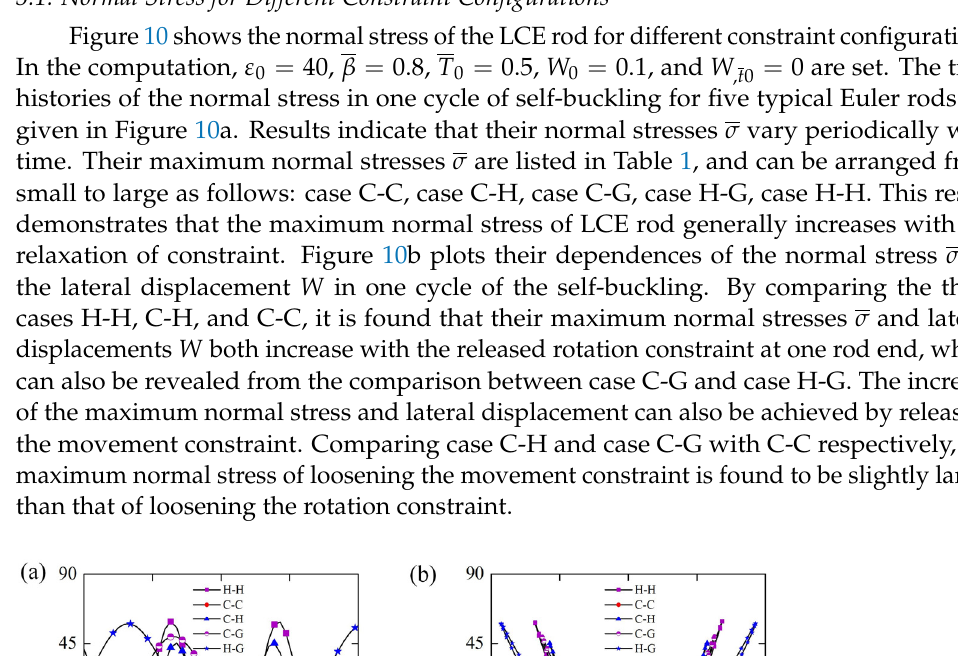
are set. Figure 11a diagrams the dependence of the equivalent